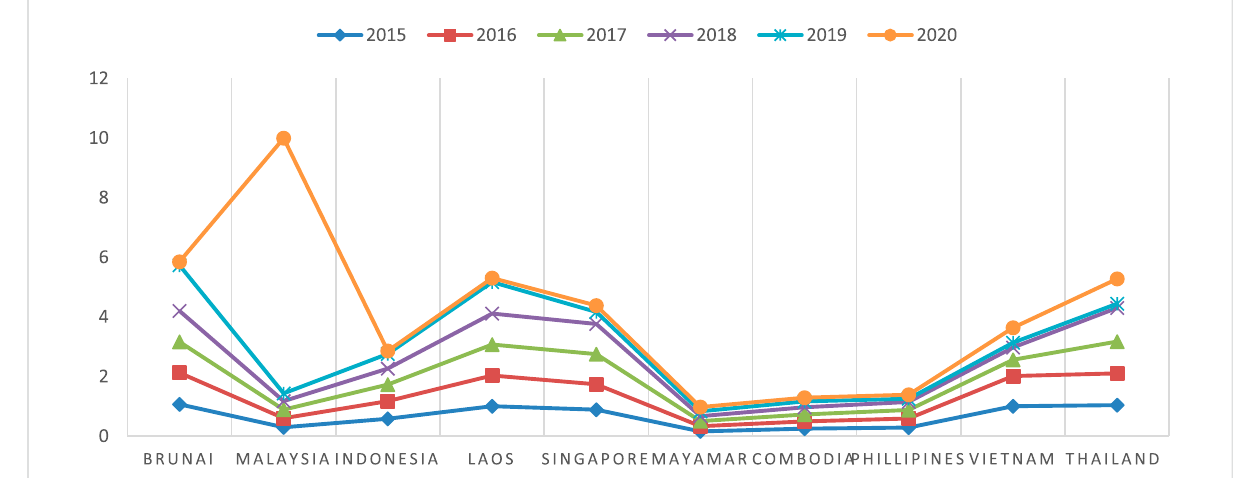
FIGURE 3 Financial stability of ASEAN